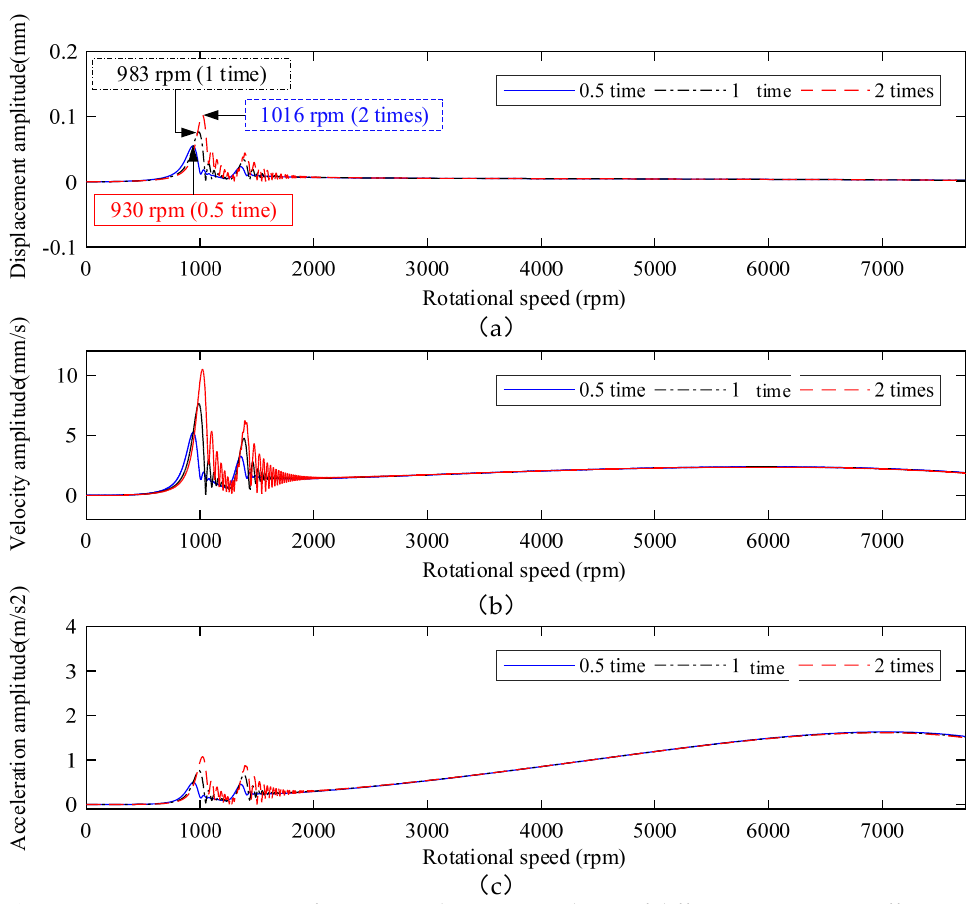
Figure 15. Dynamic response of investigated point A (node 51) of different supporting stiffness and damping coefficients of the rubber O-ring under the speed-up time of 60 s. ( a ) Displacement amplitude; ( b ) velocity amplitude; ( c ) acceleration amplitude.